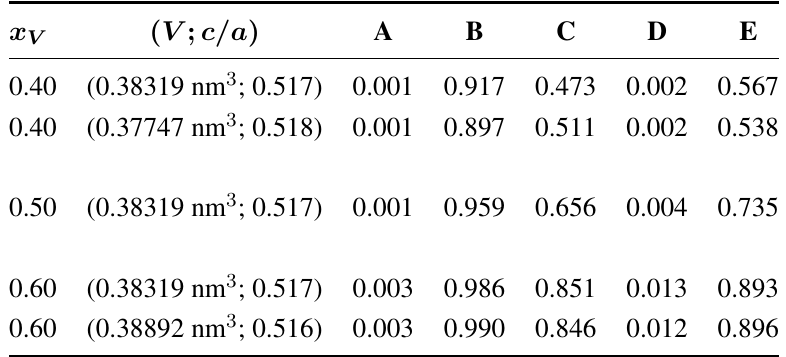
Table 6. The V site occupancies in the Fe-V system calculated for different alloy = { 0 . 40; 0 . 60 } with parameters obtained for the fixed Fe compositions x V composition or taking into account concentration and structural effects as described in the text within the DLM-LSF model at T = 1,000 K. x